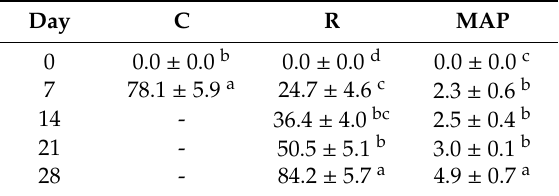
Table 1. Weight loss (%) in L. edodes under different storage conditions: room temperature (C), refrigerated at 4 °C (R), and modified atmosphere packaging at 4 °C (MAP). Data expressed as mean ± standard deviation (SD) of three samples. Different letters within the same column indicate statistically significant differences at p < 0.05.